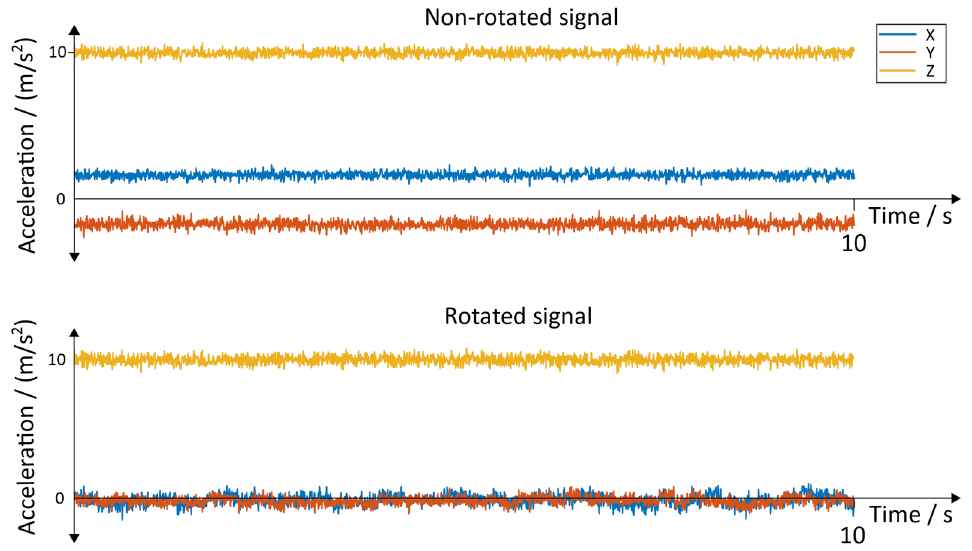
Figure 17. Non-rotated signal and rotated acceleration signals. Position of the sensor: inside of the foot .